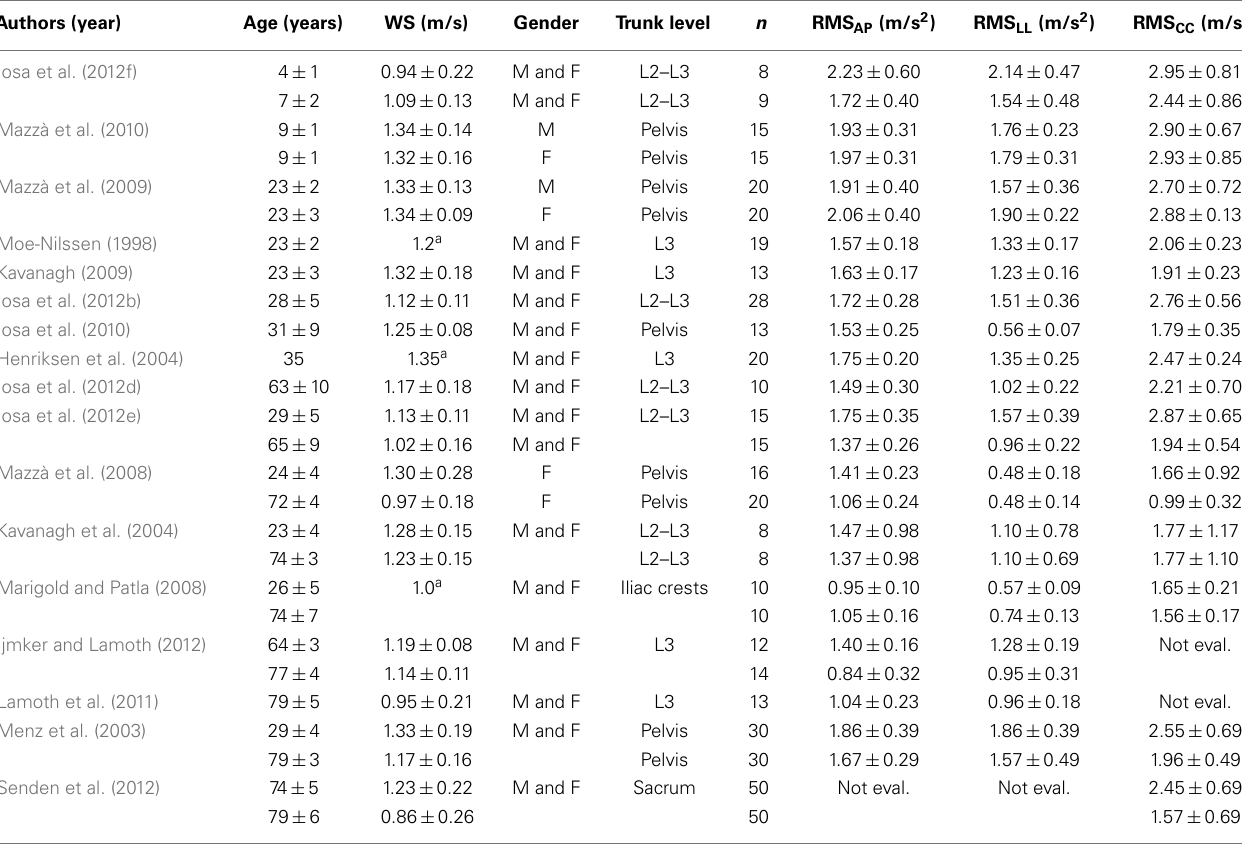
Table 1 | Healthy subject trunk accelerations during walking ordered by age